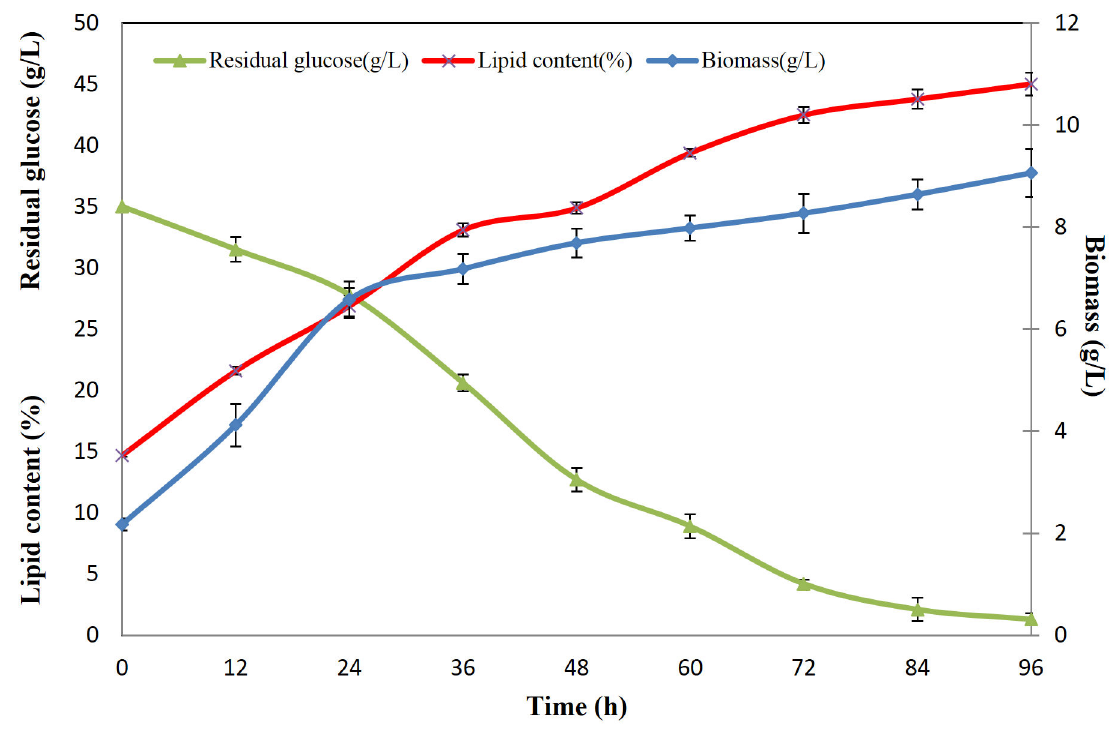
Figure 3. Substance level dynamic change of R. toruloides . Biomass (g/L), residual glucose (g/L) and lipid content (%) at different time points were